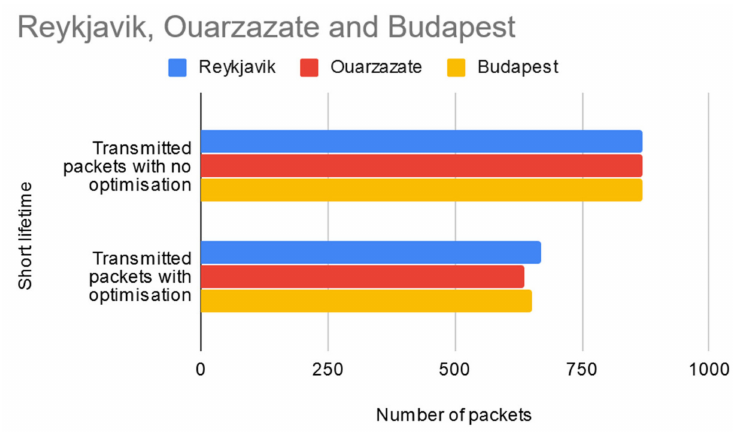
Figure 10. Test results for short network lifetime scenario.